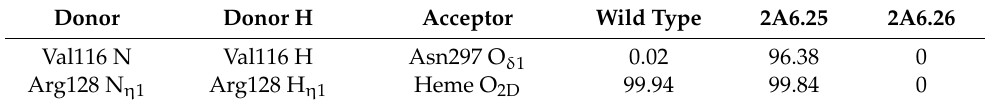
Figure 8. Structural change in CYP2A6.25 and CYP2A6.26 ( A – D ). The wild types, CYP2A6.25, and CYP2A6.26 are shown in cyan, green, and marine, respectively. Nitrogen, oxygen, and hydrogen are displayed in blue, red, and white, respectively, in the stick model. Iron is shown as an orange sphere by a model written as van der Waals radius. The red arrows indicate the shift in CYP2A6.25 and CYP2A6.26. The hydrogen atoms are omitted except for Those of Arg128. Table 6. Hydrogen bond formation involved in the structural change in CYP2A6.25 and